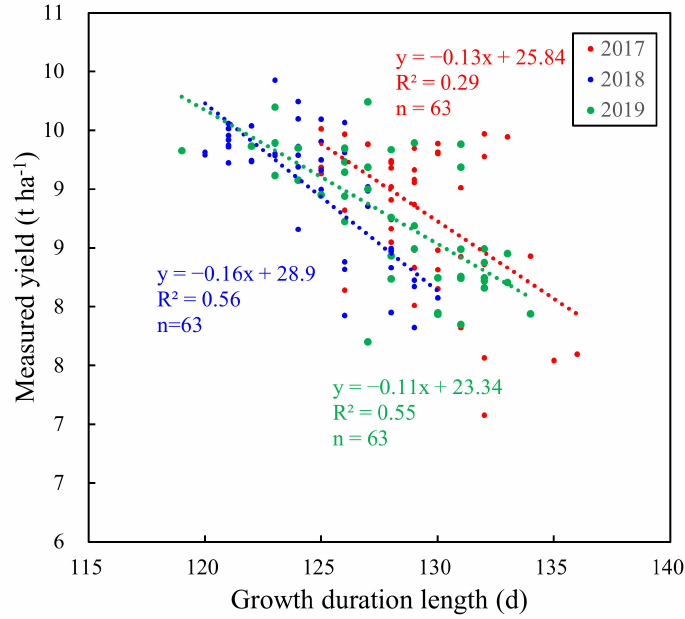
Figure 3. The relationship between measured yield and GDL for 21 replicated cultivars with three replicates across the years. Table 5. Descriptive statistics of measured yield (t ha − 1 ) and GDL for all cultivars and 21 replicated cultivars across the